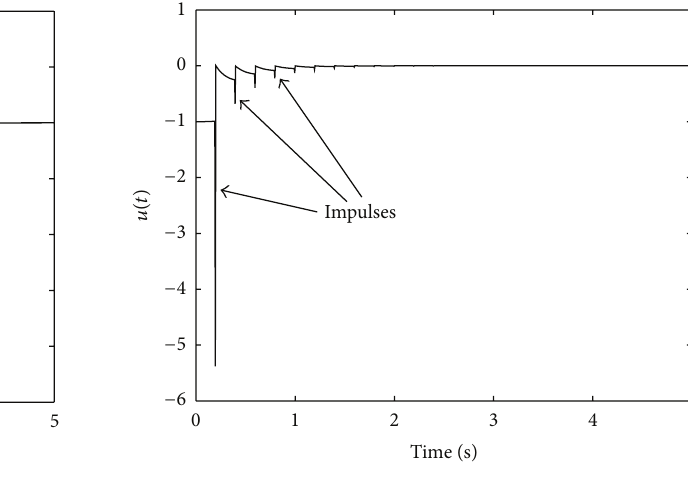
Figure 10: Control input with impulses.